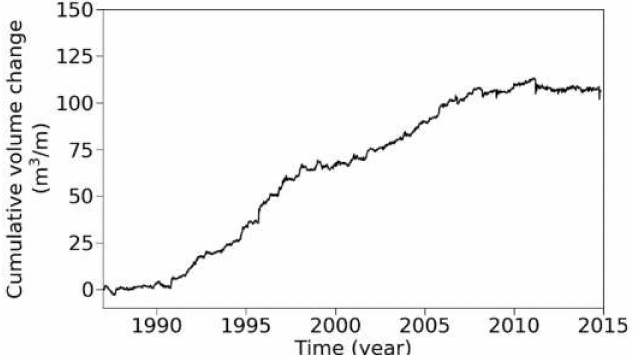
Figure 4. Temporal variation of the cumulative volume change in the investigation area based on the beach profile measured on 5 January